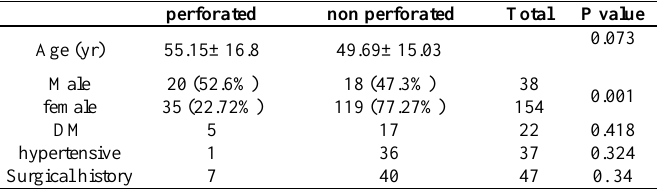
Table 1: Preoperative Clinical Characteristics associated with Accidental Gallbladder Perforation